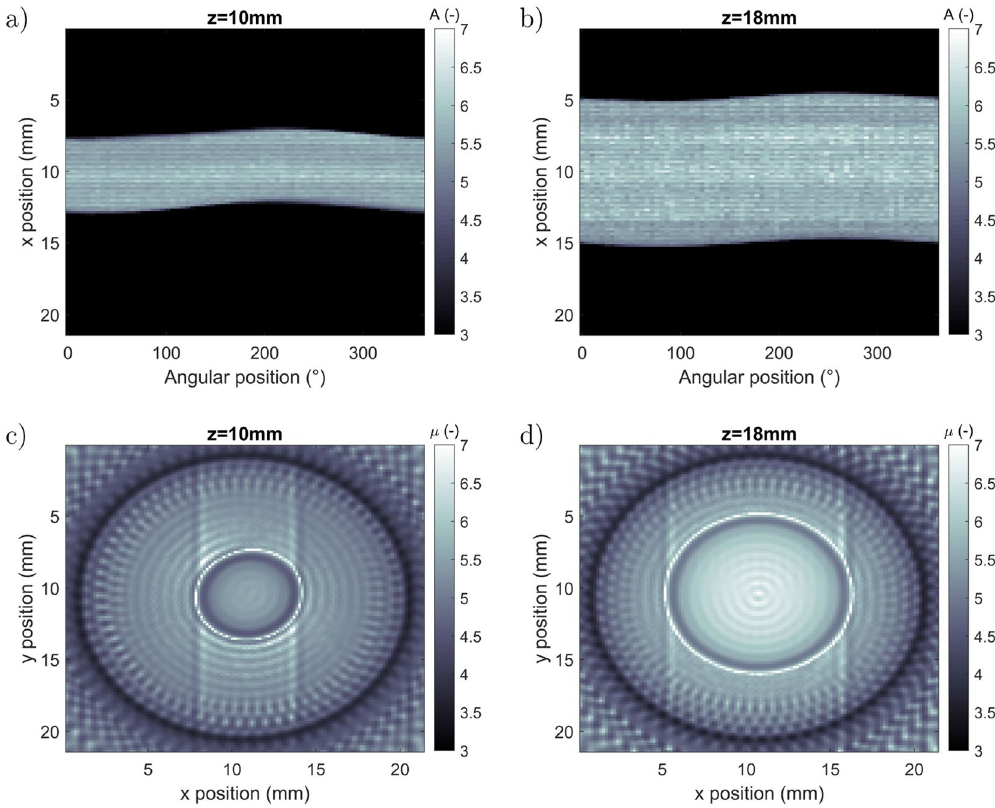
Figure 4. ( a ) Sinogram of the absorbance extracted at z = 10 mm (thread of the screw) over all of the angular positions, ( b ) sinogram of the absorbance extracted at z = 18 mm (head of the screw) over all of the angular positions, ( c ) reconstructed slice (x and y) at z = 10 mm for the thread of the screw and ( d ), reconstructed slice (x and y) at z = 18 mm for the head of the screw. (Created with MATLAB 2020a, https ://mathw